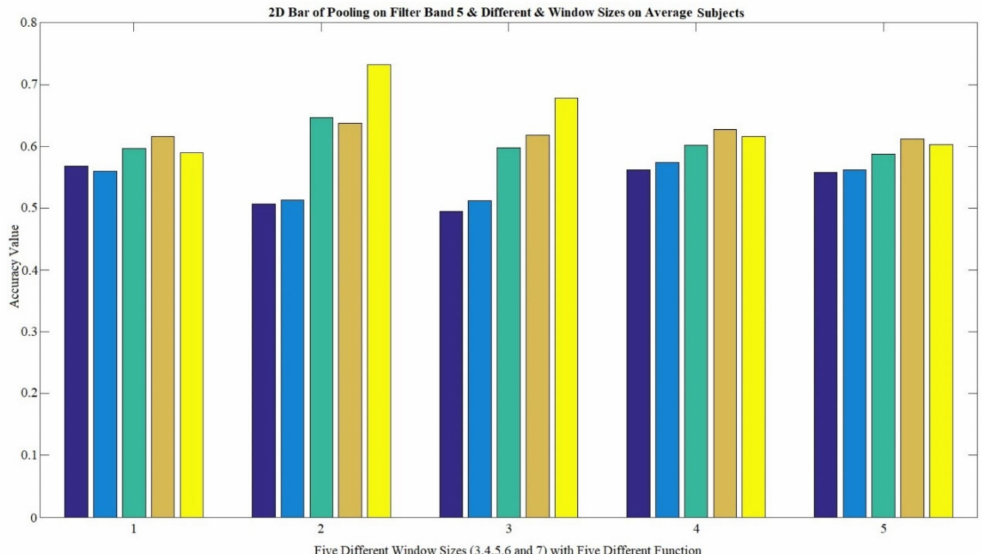
Figure 11. Reduction data based on pooling model on average subjects with filter banks with different window sizes for FB 5 and RF for 10